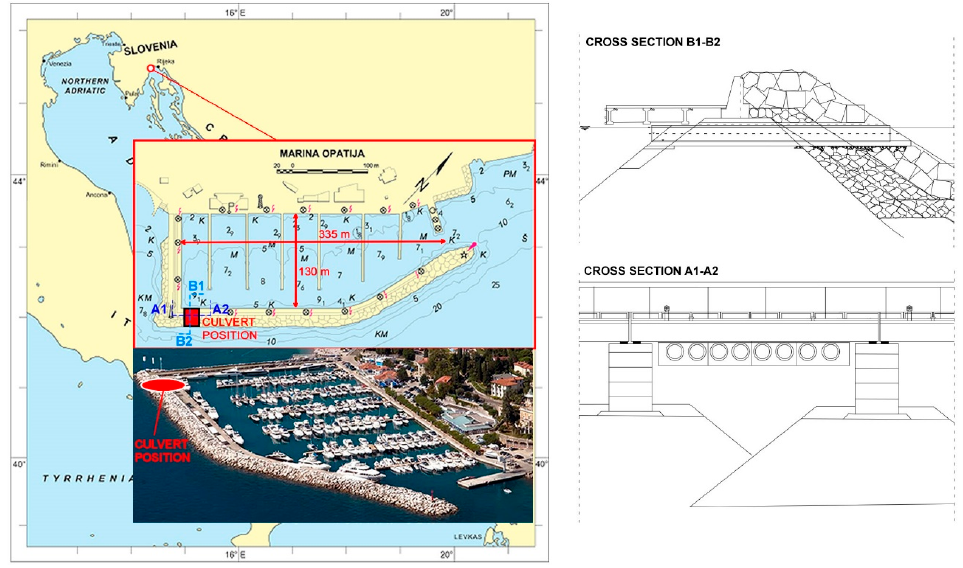
Figure 2. Situation map and figure of ACI marina Opatija.